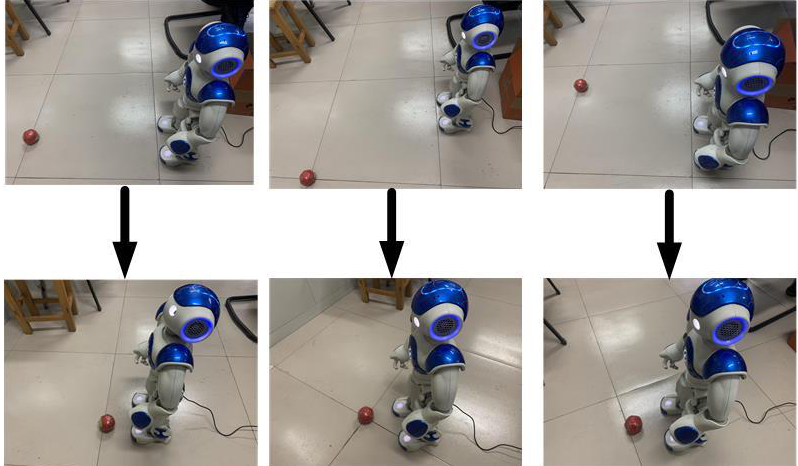
Figure 13. Experimental results based on the NAO robot.